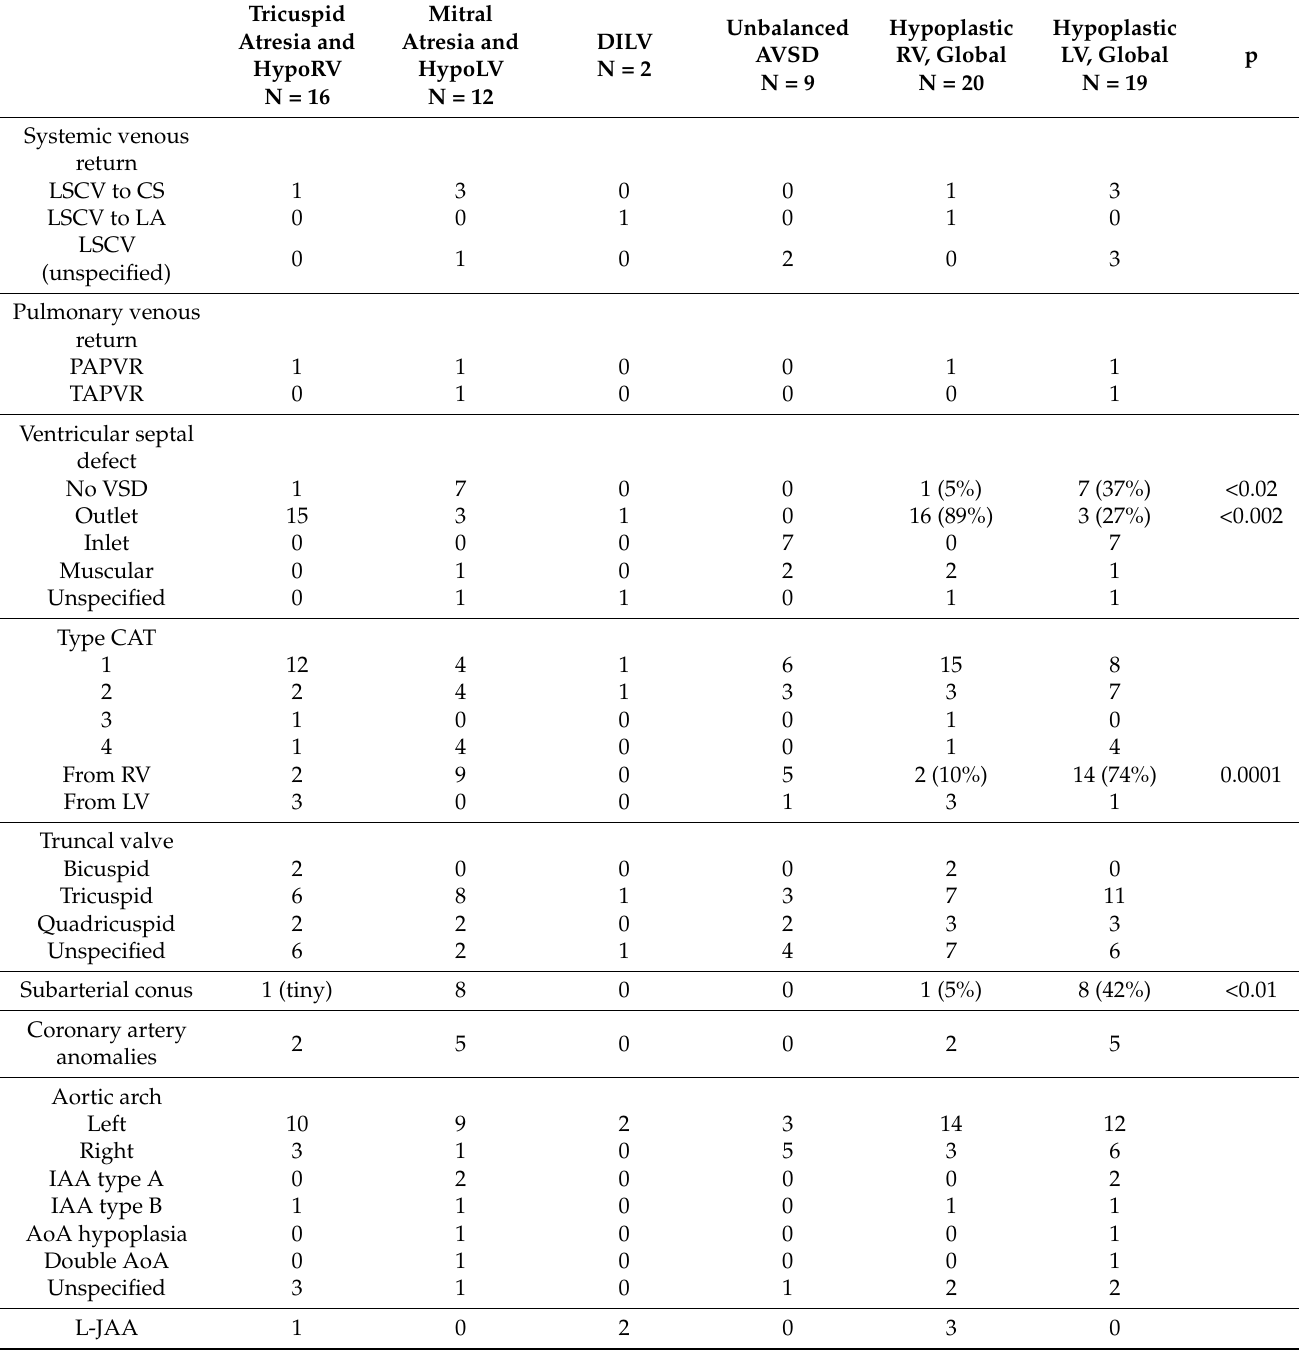
Table 3. Distribution of the anatomical characteristics of the